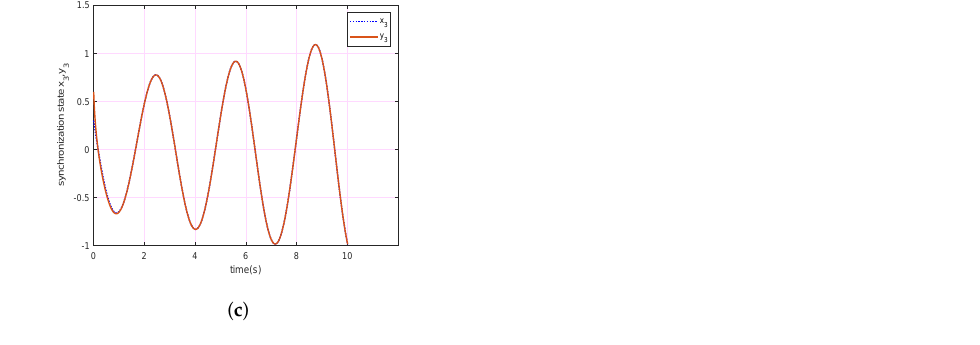
Figure 2. State trajectories of drive and slave systems in Example 1: ( a ) x 1 v.s. y 1 , ( b ) x 2 v.s. y 2 , ( c ) x 3 v.s. y 3 .